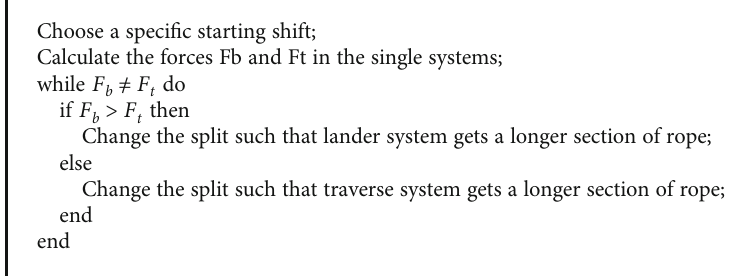
(traverse side), F G (lander side), and F G (expander part). t l e